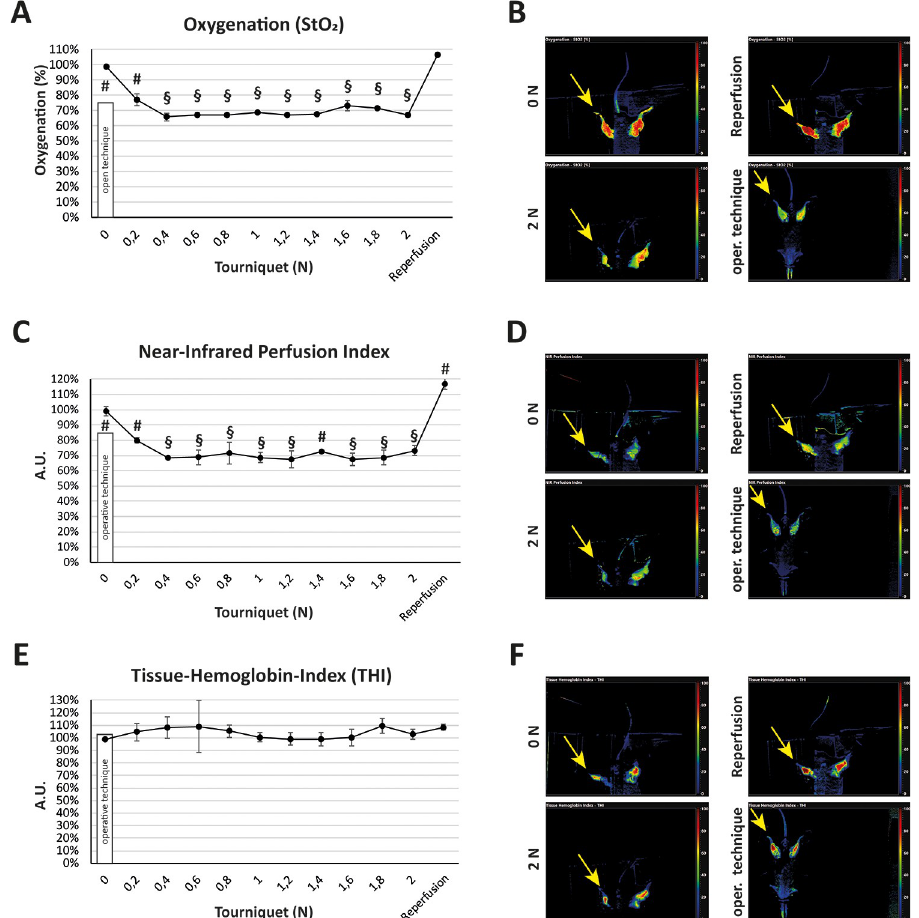
Fig 3. Measurement of oxygenation, perfusion and tissue hemoglobin in the tourniquet and operative clamping model with a hyperspectral camera system. (A) Using the TIVITA Tissue system, acquisition of the tissue Oxygenation (StO2) showed a significant reduction of oxygenation in the low-pressure tourniquet group at a force of 0.4 N with no further reduction of oxygenation by rising pressure. The low-pressure tourniquet group showed a higher reduction of oxygenation than the operative clamping method. (B) Live images of the oxygenation visualization exemplary at a force of 0 N, 2 N, after reperfusion and with the open clamping technique. The yellow arrow marks the compromised hind limb. (C) Measurement of the near-infrared (NIR) perfusion index showed a significant steady reduction of the hind limb perfusion starting with a force of 0.4 N. In the tourniquet group this force showed a significantly higher reduction of perfusion than the operative clamping technique. (D) Live images of the NIR exemplary at a force of 0 N, 2 N, after reperfusion and with the open clamping technique. The yellow arrow marks the compromised hind limb. (E) Measurement of Tissue-Hemoglobin-Index showed no significant change either in the tourniquet group or in the operative clamping group compared to control (0 N). (F) Live images of the Tissue- Hemoglobin-Index exemplary at a force of 0 N, 2 N, after reperfusion and with the open clamping technique. The yellow arrow marks the compromised hind limb. Results are shown as means ± SEM. P-value: # < 0.05; § < 0.001 (two sample t-test), n =